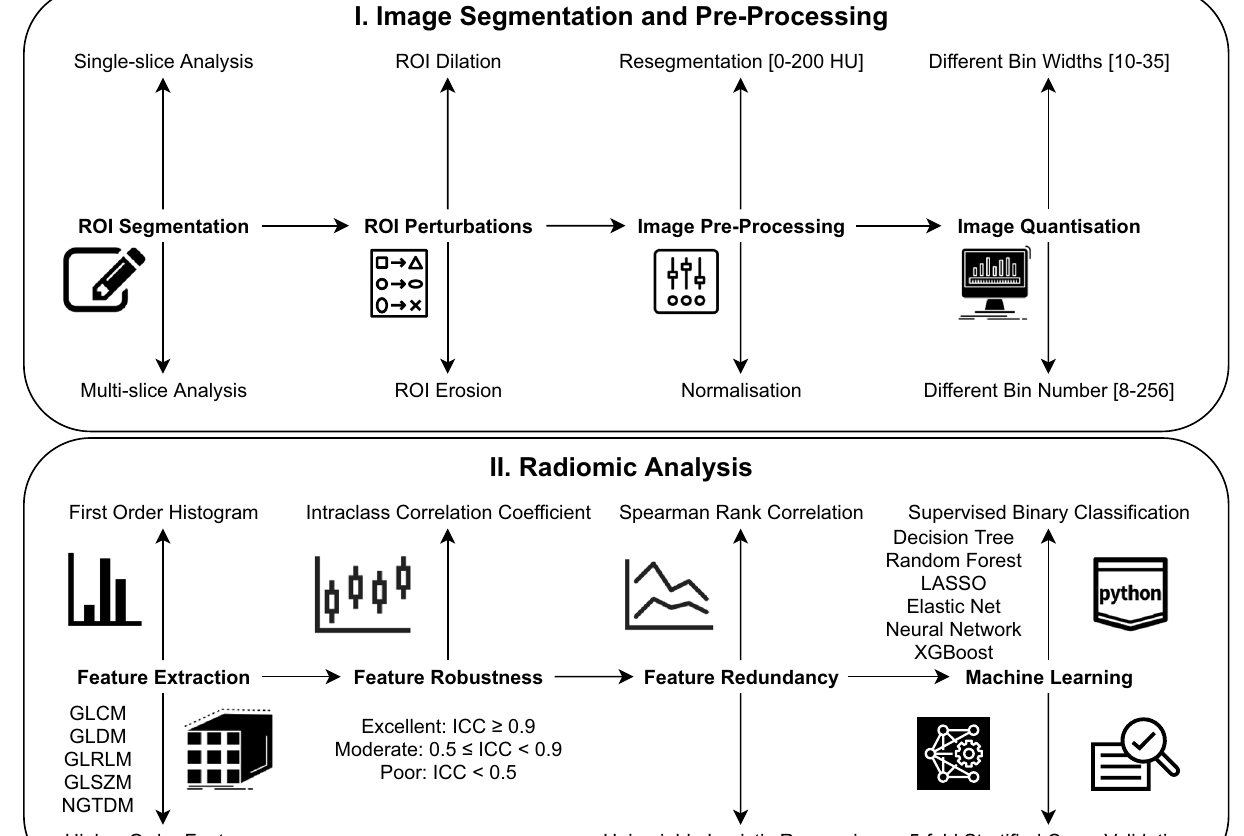
Figure 5. Radiomics workflow. The upper panel illustrates the steps taken from manual segmentation of the carotid CTA images to create ROIs for single-slice analysis (and VOIs for multi-slice analysis) to segmentation mask perturbations, prior image normalisation or resegmentation and image quantisation. The lower panel outlines the subsequent process of radiomic features extraction, robustness analysis and machine learning for the differentiation of culprit versus non-culprit carotid arteries. The predictive ability of the classifiers was assessed via five-fold stratified